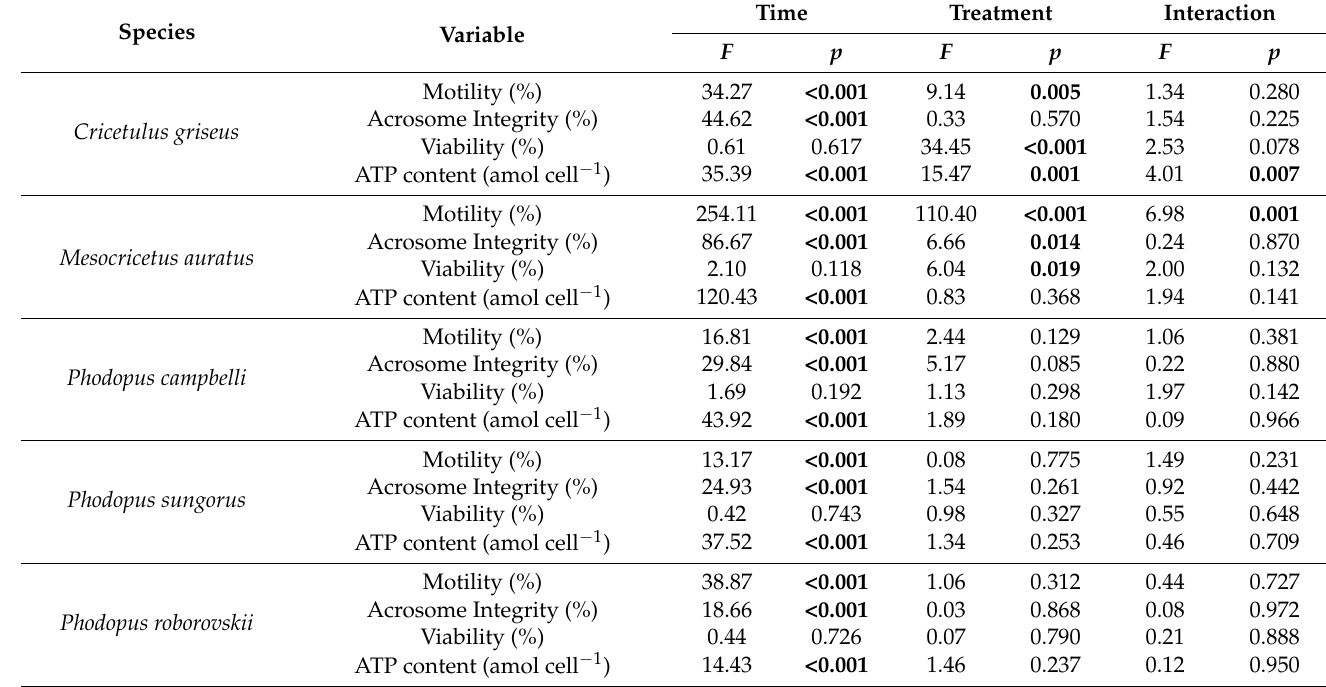
Table 4. Effect of penicillamine, hypotaurine, and epinephrine (PHE) on sperm motility, acrosome integrity, viability, and ATP content, in five hamster species. F and p values correspond to repeated measures ANOVA using time of incubation and treatment (control vs. PHE) as independent variables and sperm parameters as dependent variables. Significant differences between treatments and times of incubation ( p < 0.05) are shown in